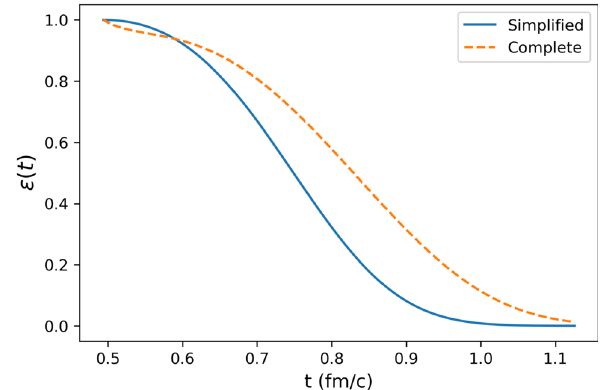
Fig. 2 E ( t ) , the fraction of the initial energy contained in the hard sector, for the three cases – static, Bjorken (isentropic) expansion and linear rise in T – as a function of time